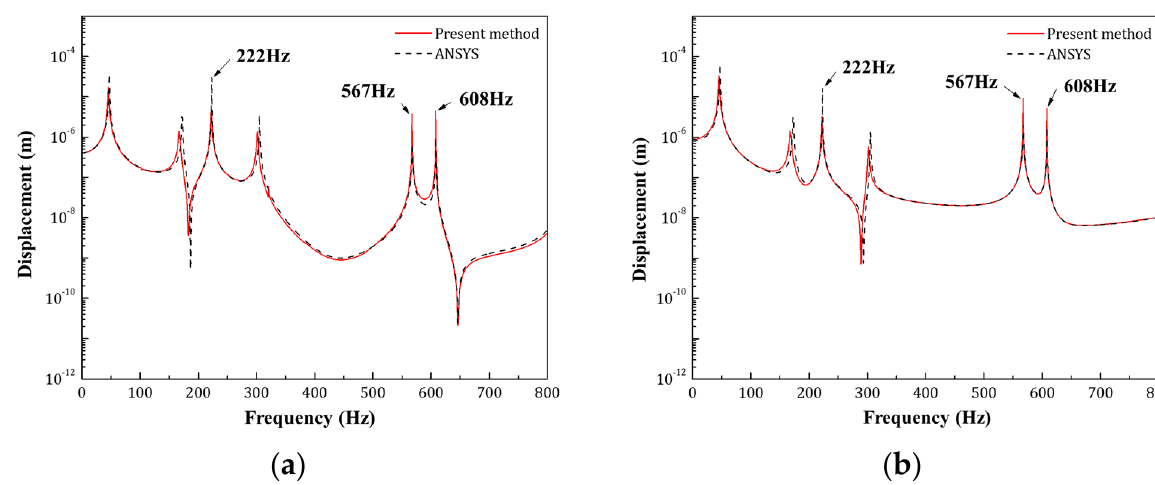
Figure 11. The displacement response of the observation points on the upper face sheet: ( a ) L /3 of the top face sheet; ( b ) L /2 of the top face sheet.